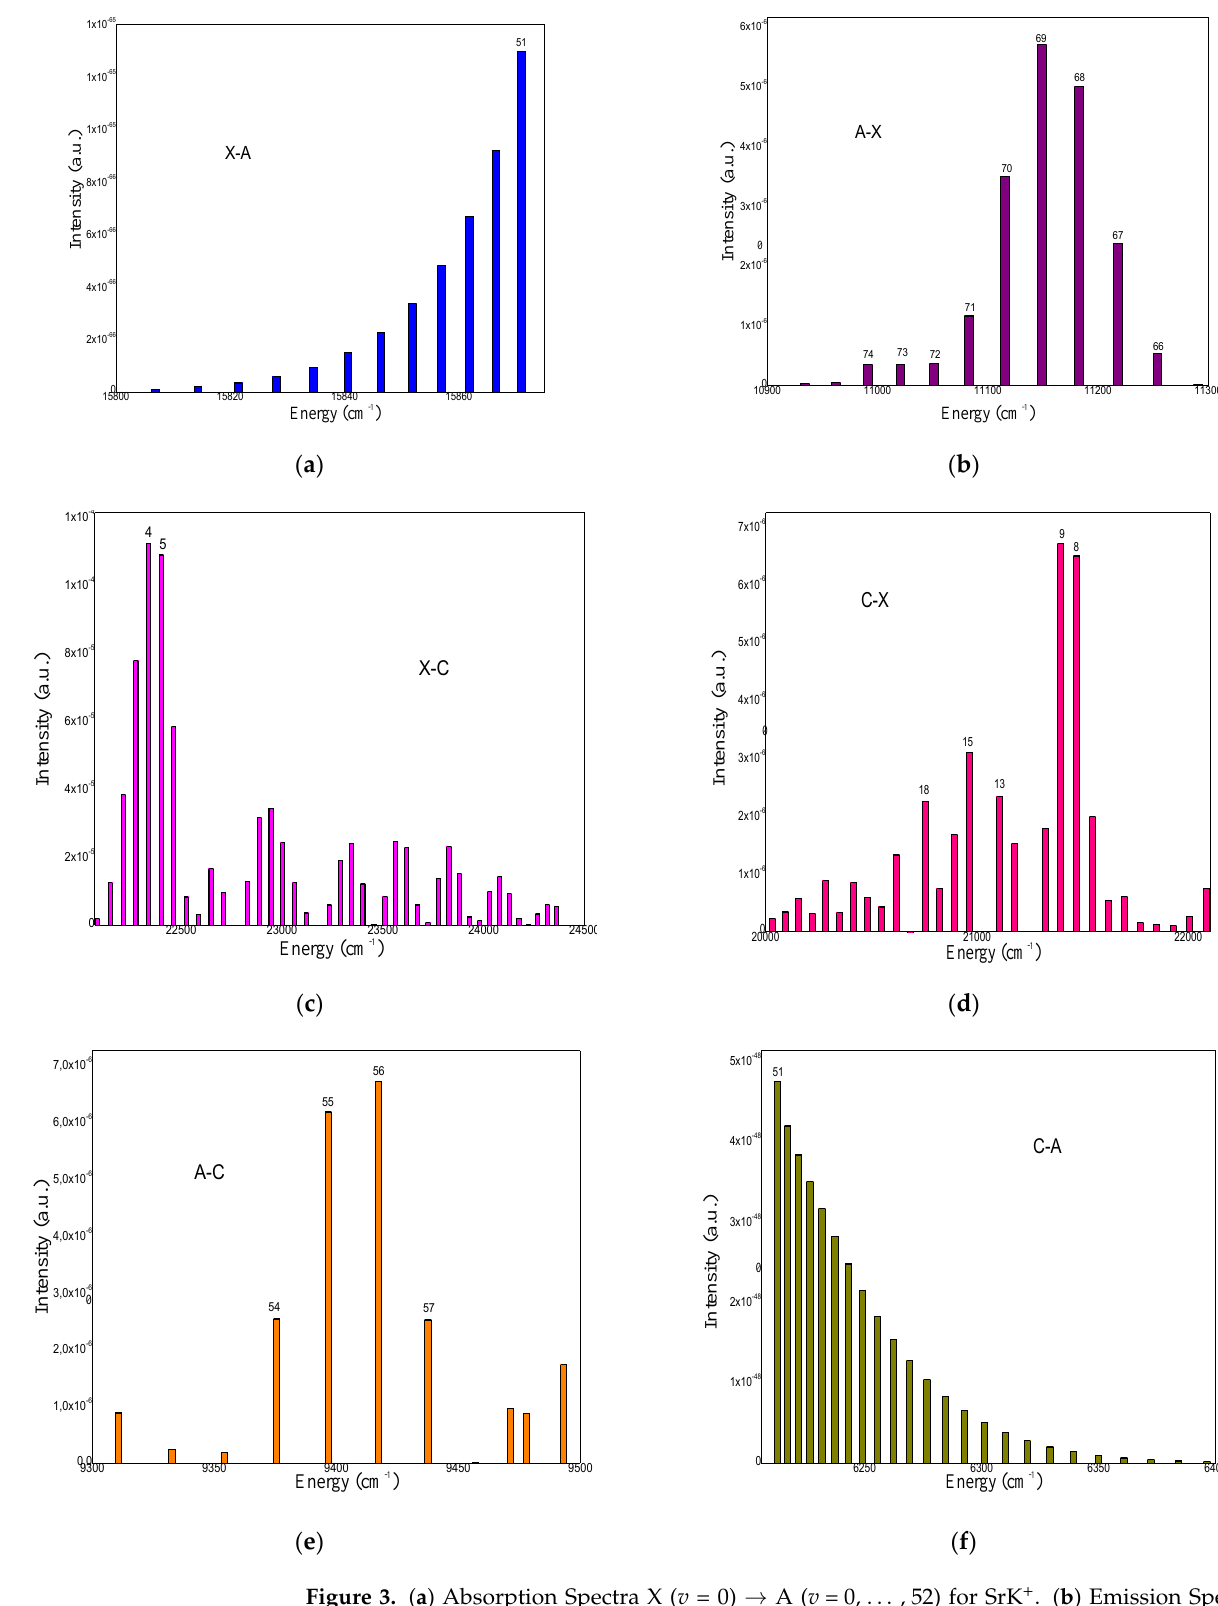
Figure 3. ( a ) Absorption Spectra X ( v = 0) → A ( v = 0,…,52) for SrK + . ( b ) Emission Spectra A ( v = 0) → X ( v = 0,…,28) for SrK + . ( c ) Absorption Spectra X ( v = 0) → C ( v = 0,…,141) for SrK + . ( d ) Emission Spectra C ( v = 0) → A ( v = 0,…,52) for SrK + . ( e ) Absorption Spectra A ( v = 0) → C ( v = 0,…,141) for SrK + . ( f ) Emission Spectra C ( v = 0) → X ( v = 0,…, 28) for SrK + .